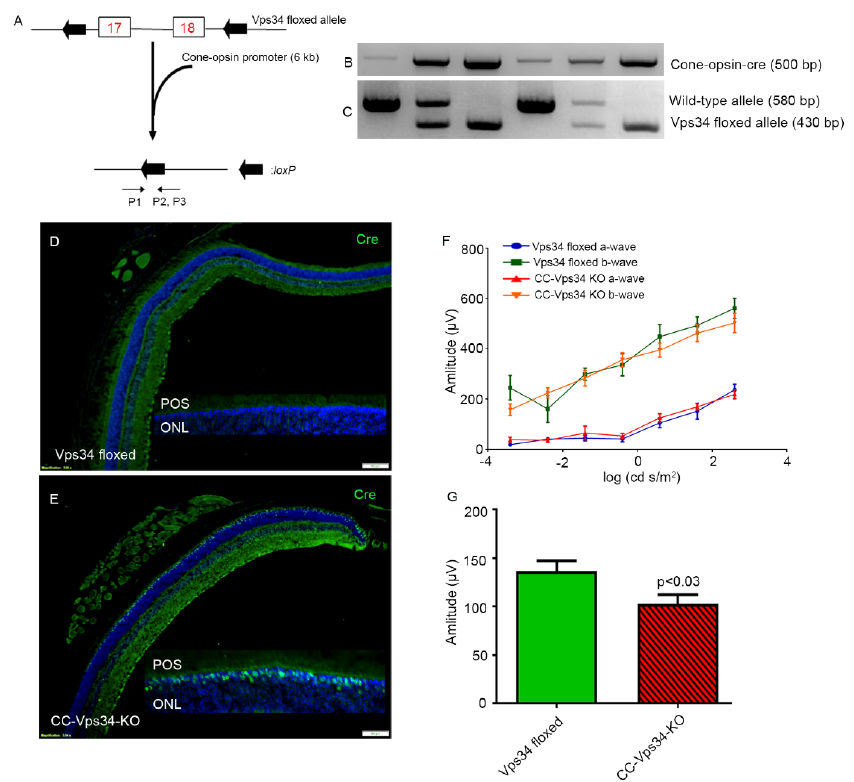
Figure 3. Characterization and retinal function of cone-conditional Vps34 KO mice. Schematic diagram of exon 17 and 18 floxed Vps34 loci ( A ). Cone photoreceptor-specific Vps34 knockout mice were generated by breeding mice with a floxed Vps34 with mice that express Cre recombinase under the control of human red / green opsin promoter (6.0 kb). Primer pairs P1, P2, and P3 were used to identify the wild-type and floxed Vps34 alleles ( A ). PCR diagnostic for cone opsin Cre ( B ) and floxed Vps34 and wild-type (WT) genes ( C ) was performed using mouse tail DNA samples. Immunohistochemical analysis of Cre recombinase immunolabeling was performed in Vps34-floxed ( D ) CC-Vps34 KO ( E ) retinas harvested from littermates. Inset: enlarged view between photoreceptor outer segments (POS) and outer nuclear layer (ONL). Scotopic a-wave ( F ), scotopic b-wave ( F ), and photopic b-wave ( G ) analyses were performed on 6-week-old Vps34-floxed and CC-Vps34 KO mice. Scotopic a-wave and scotopic b-wave amplitudes were carried out at different flash intensities (−3.4, −2.4, −1.4, −0.4, 0.6, 1.6, and 2.6 log cd s/m 2 ). Photopic b-wave amplitudes were performed at a flash intensity of 3.3 log cd s/m 2 . Data are mean ± SEM ( n = 16). Significance, if any, is indicated on each panel. Full-length blots are presented in the Supplementary Materials.